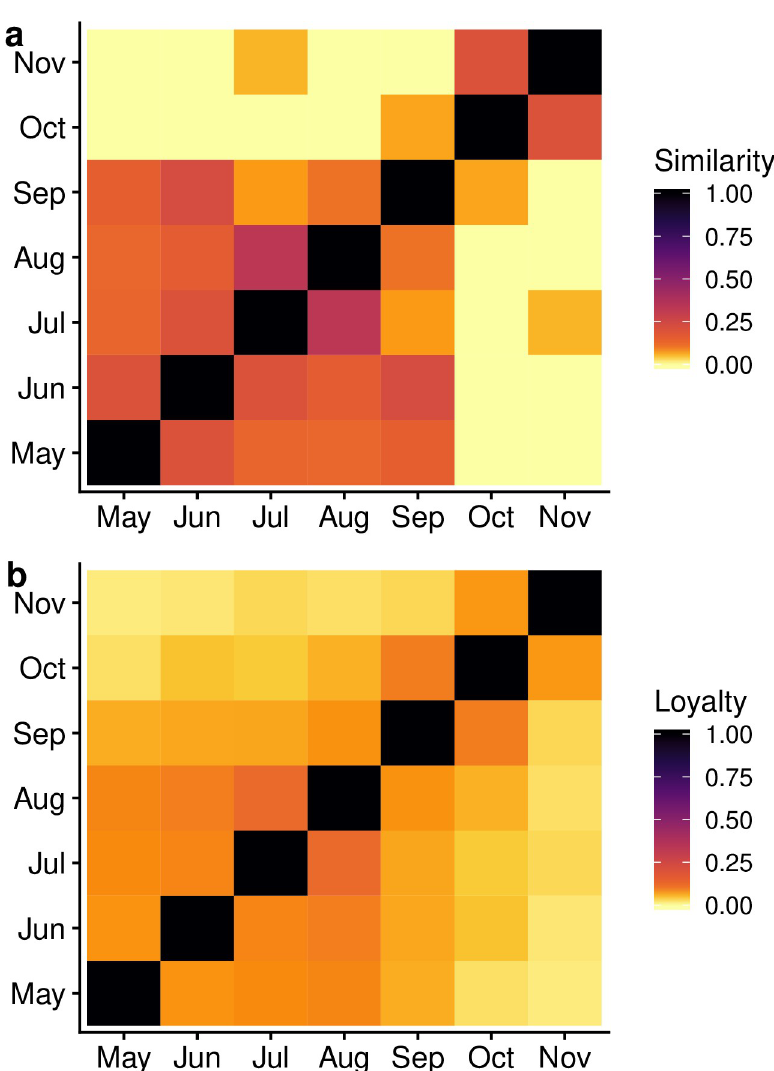
Fig 6. The proportion of (a) highly connected nodes that retained their position, and (b) preserved direct contacts between locations, in consecutive monthly networks. Highly connected nodes were defined as those within the top 10% of values according to their average